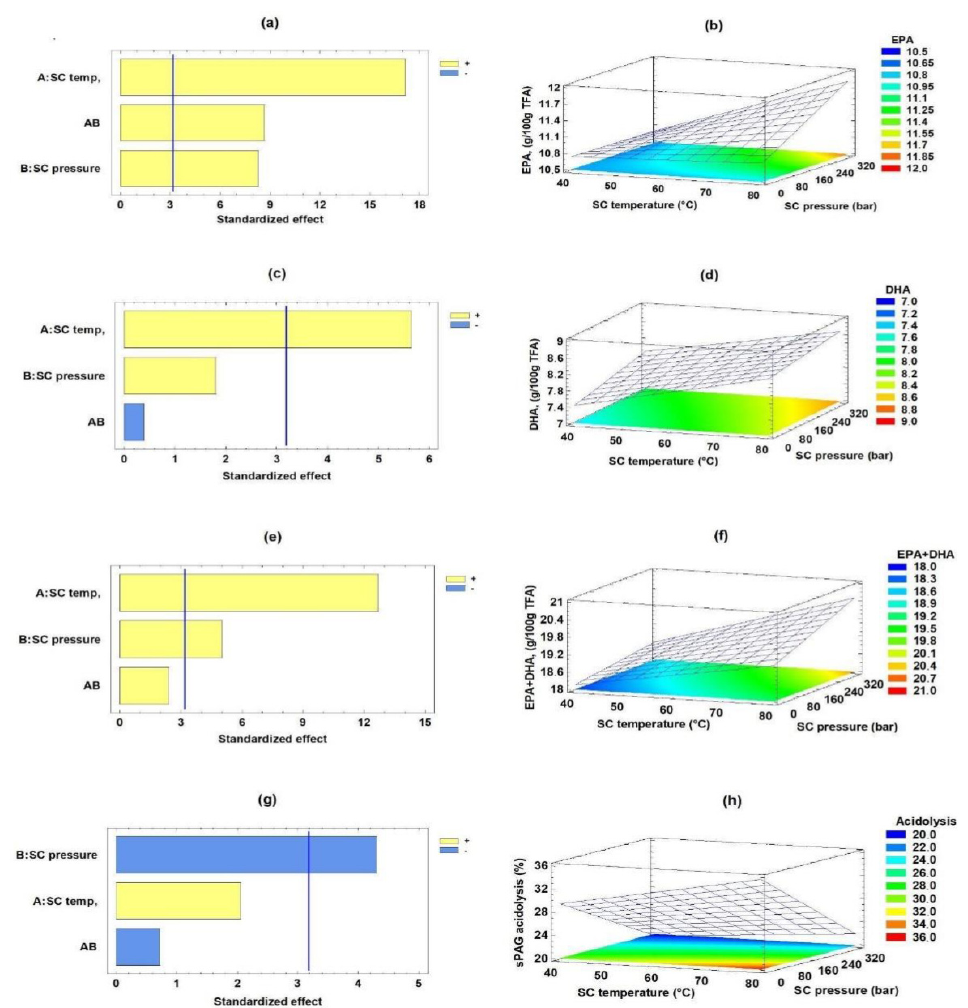
Figure 1. Effect of CO 2 SC temperature and CO 2 SC pressure on the sPAG synthesis process. Stand- ardized Pareto diagrams. Panels ( a , c , e , g ), (EPA, DHA and EPA + DHA content (g/100 g TFA) and phenolic acidolysis (%), respectively). Estimated response surface and contour response surface. Panels ( b , d , f , h ), (EPA, DHA and EPA + DHA content (g/100 g TFA), phenolic acidolysis (%) content, respectively).